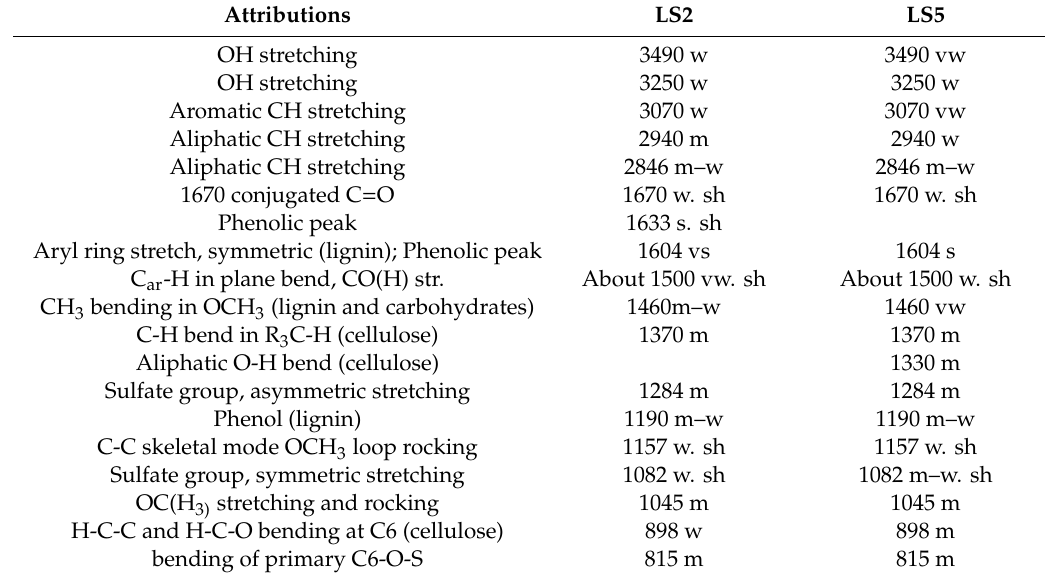
Table 2. Main bands observed in the Raman spectra of humates LS2 and LS5. S = strong; m = medium; w = weak; v = very; sh = shoulder.